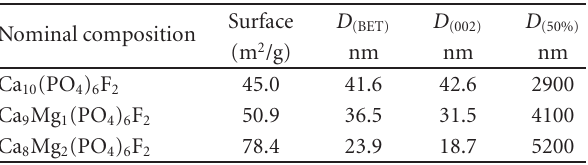
Table 2: Characteristics of as-prepared samples. Nominal